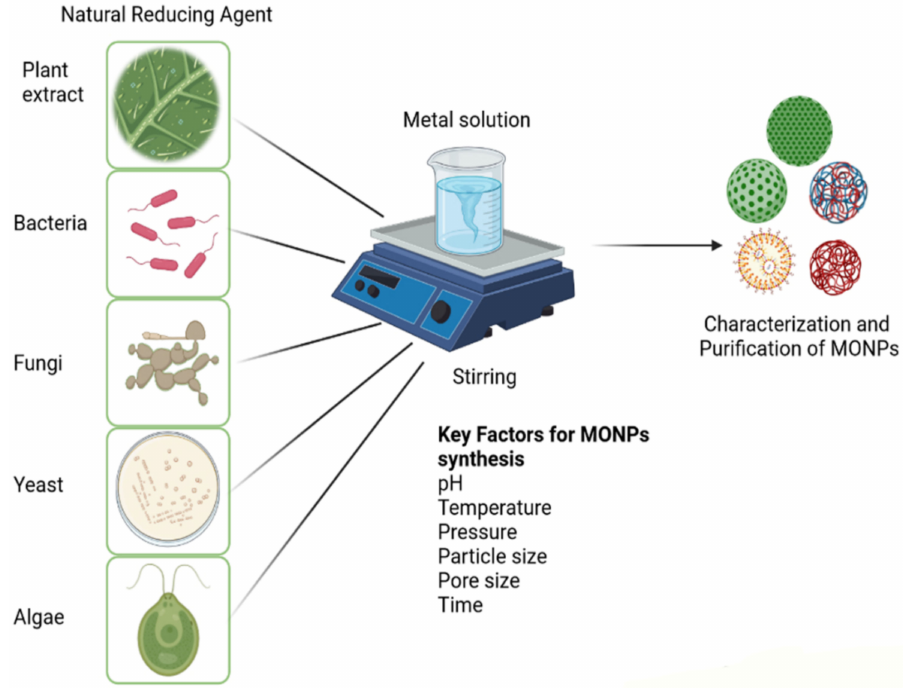
Figure 1. The green synthesis of metal oxide nanoparticles (MONPs) is represented schematically. Created with Biorender.